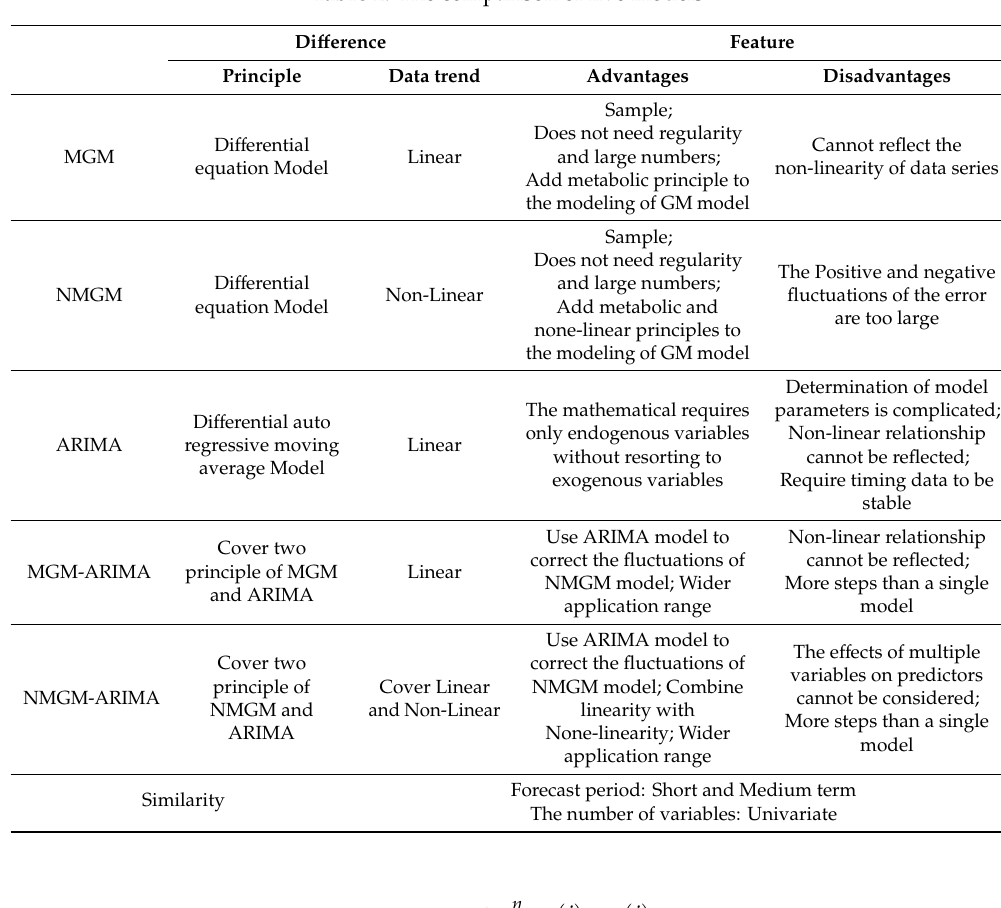
Table 2. The comparison of five